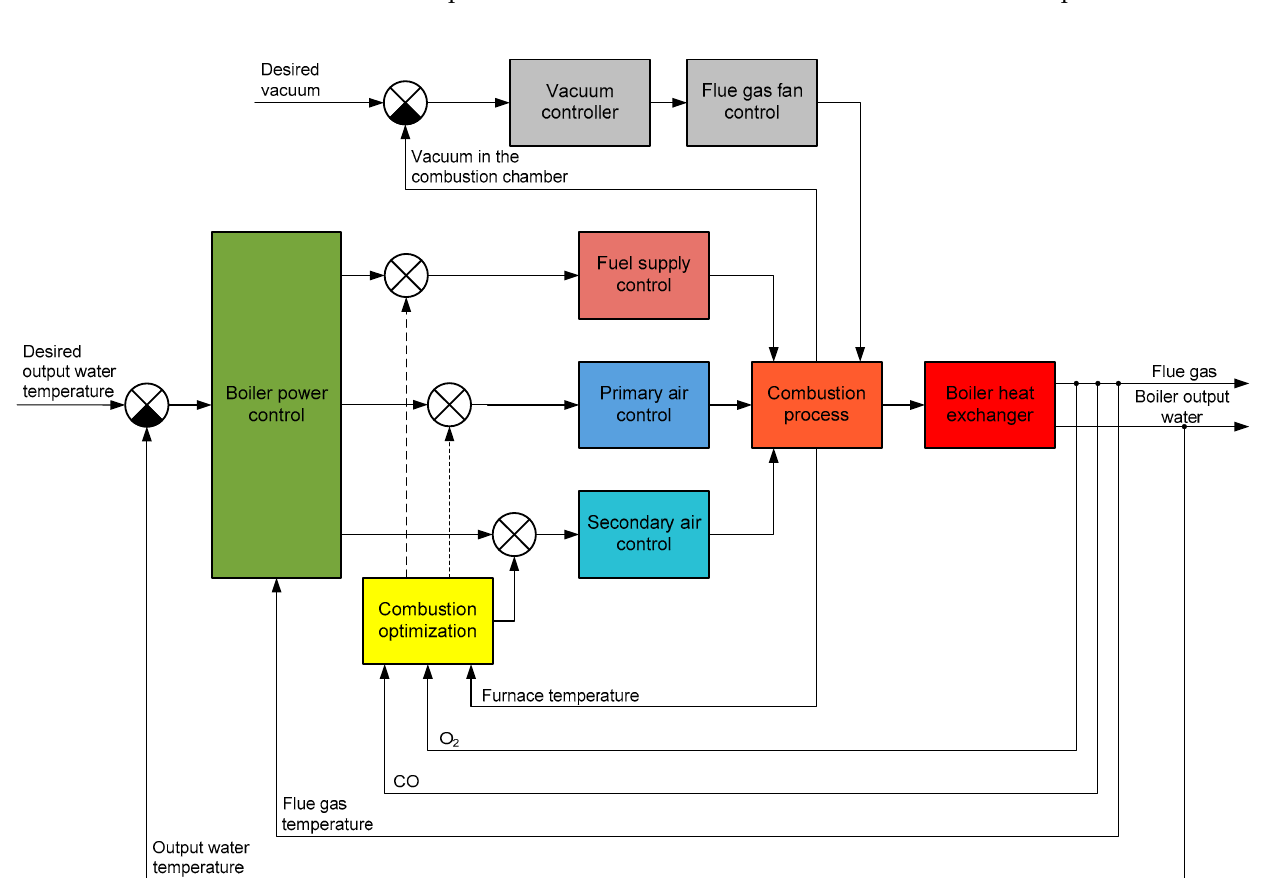
Figure 3. A principle block diagram of the biomass combustion process control.